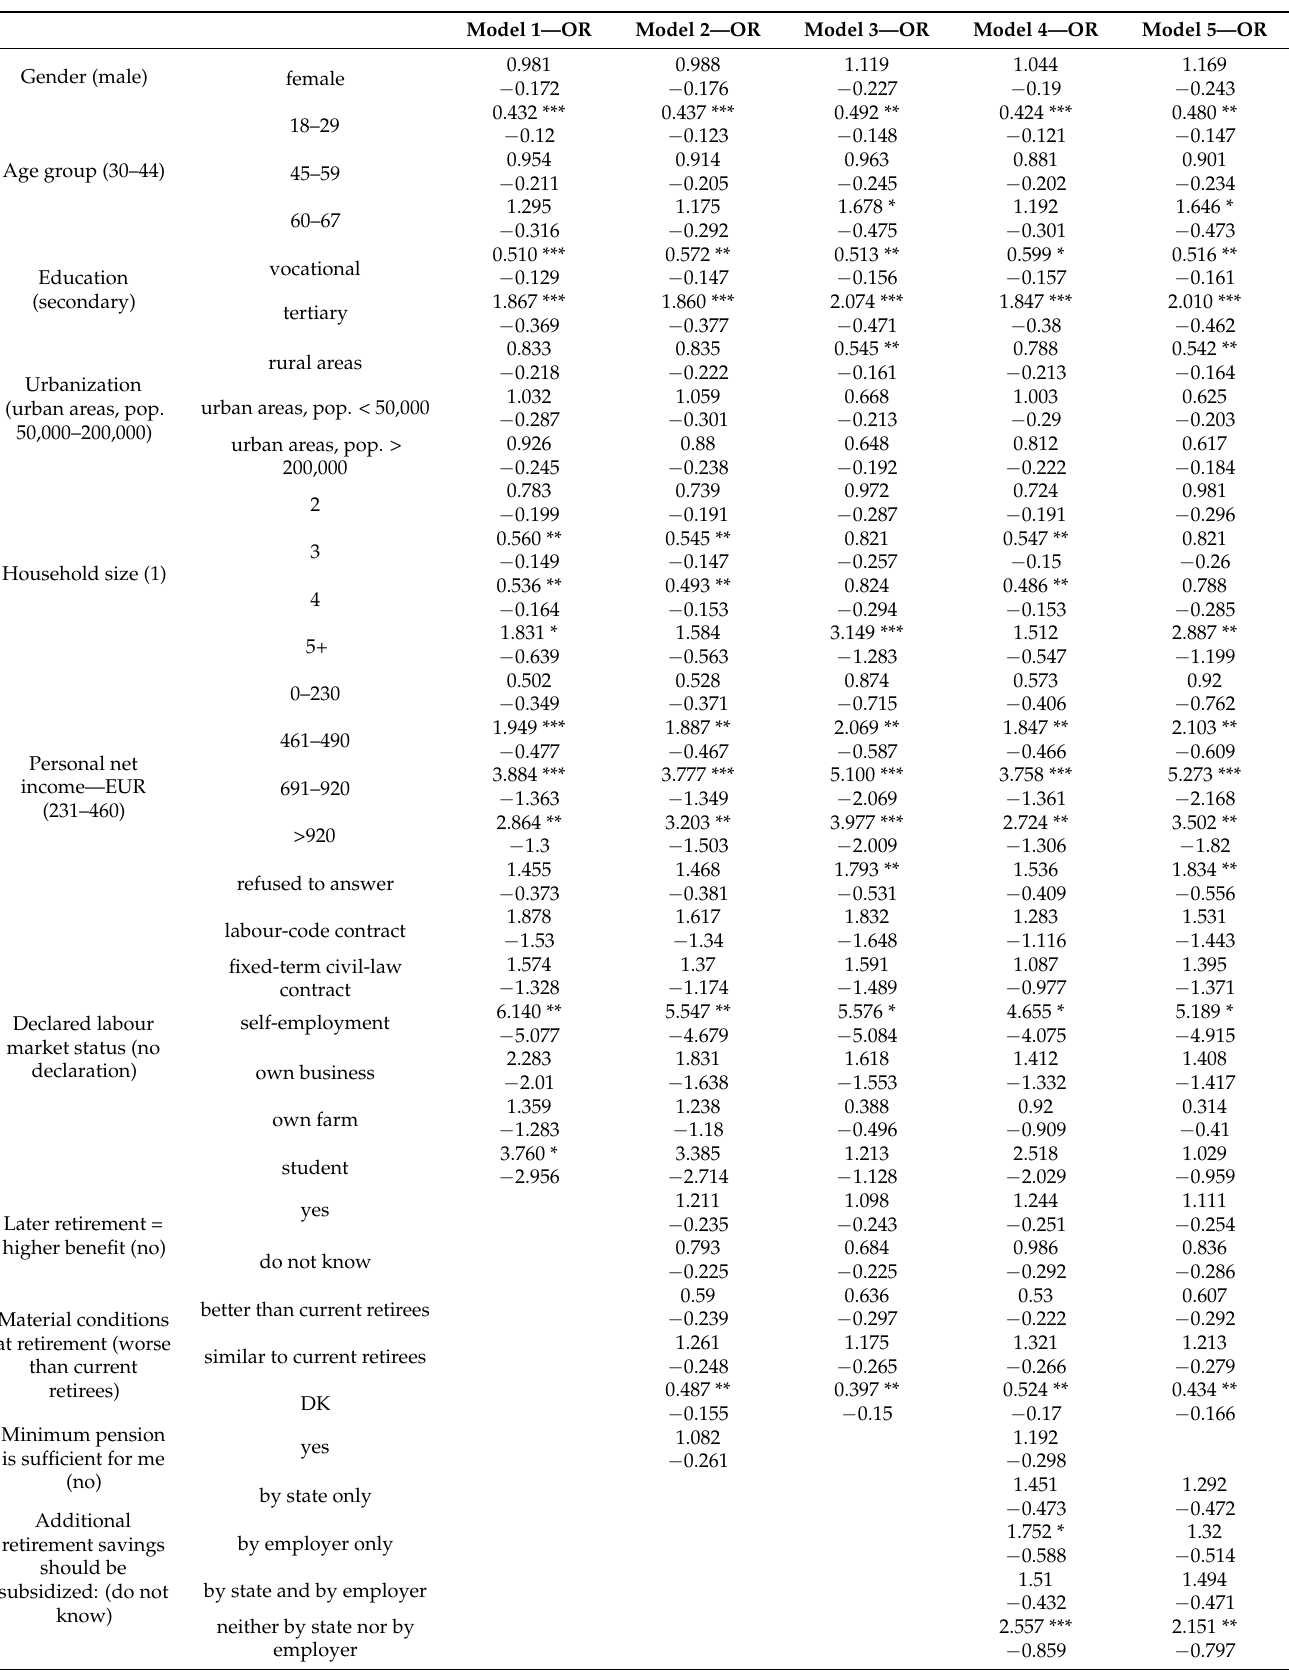
Table 4. Determinants of taking additional actions for retirement